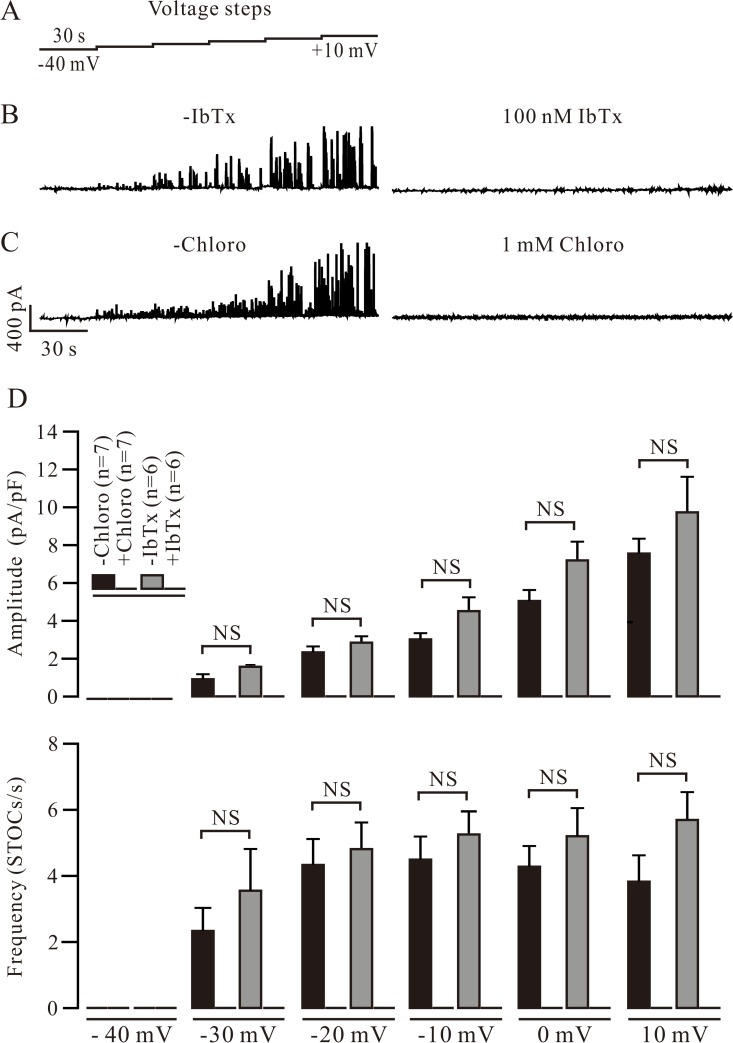
Chloroquine (chloro) blocks BK-mediated STOCs.(A) Mouse tracheal smooth muscle cells were patched using a whole-cell configuration and held at −40 mV. STOCs were recorded using a series of 30 s voltage steps from −40 through +10 mV. (B, C) Following the addition of the selective BK blocker iberiotoxin (IbTx, 100 nM, in 6 cells) or chloro (1 mM, in 7 cells), STOCs were abolished. (D) The averaged amplitude and frequency of STOCs in the absence and presence of IbTx. NS (not significant) denotes p > 0.05. These data indicate that chloro blocks BK-mediated STOCs.